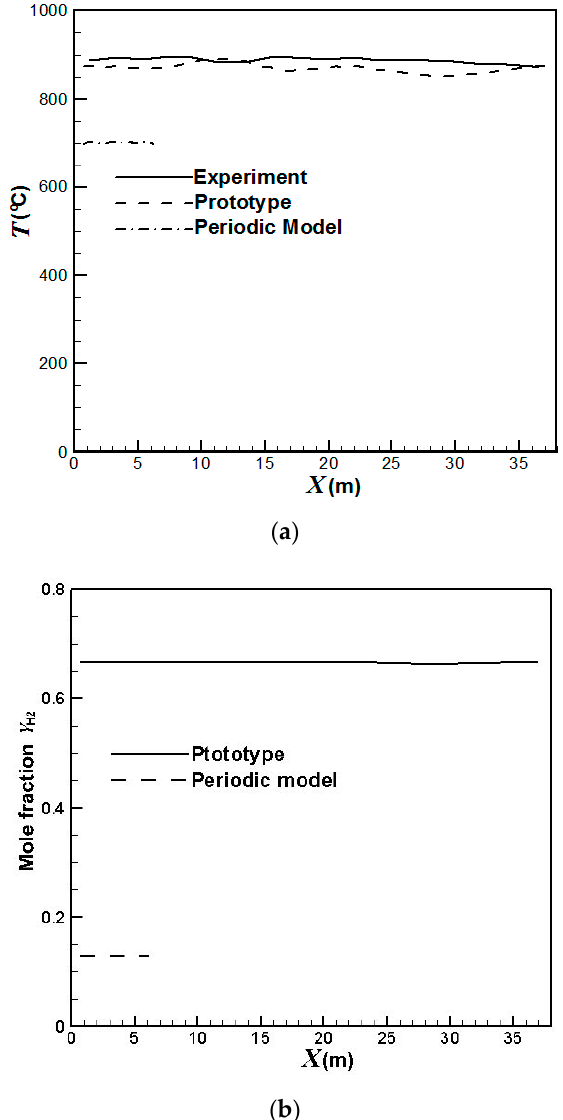
Figure 2. Comparison of the catalyst tube temperatures and hydrogen yields using the prototype and the periodic model: ( a ) Average temperatures at the outer surfaces of the catalyst tubes; ( b ) Hydrogen yields at the outlets of the catalyst tubes.